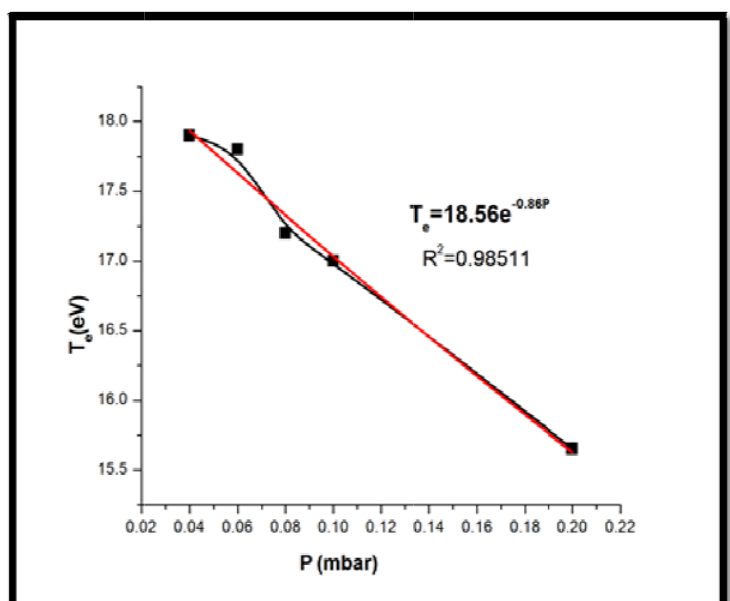
Fig g.3: Electron It is cle that the elec decr reases wit pres ssure. The refe The vacu incr electron co